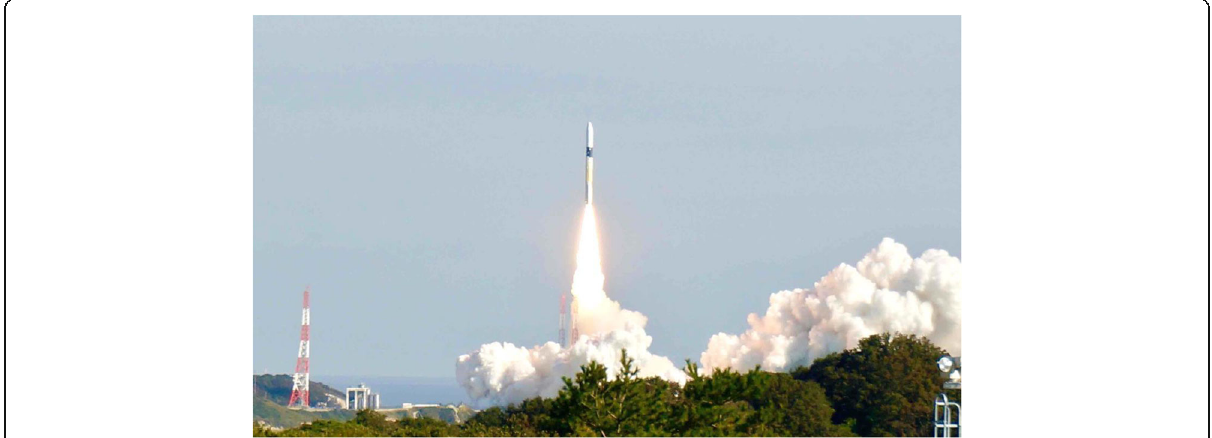
Fig. 1 GCOM-C satellite launch on the H-2A rocket from Tanegashima Space Center, Japan, on December 23,